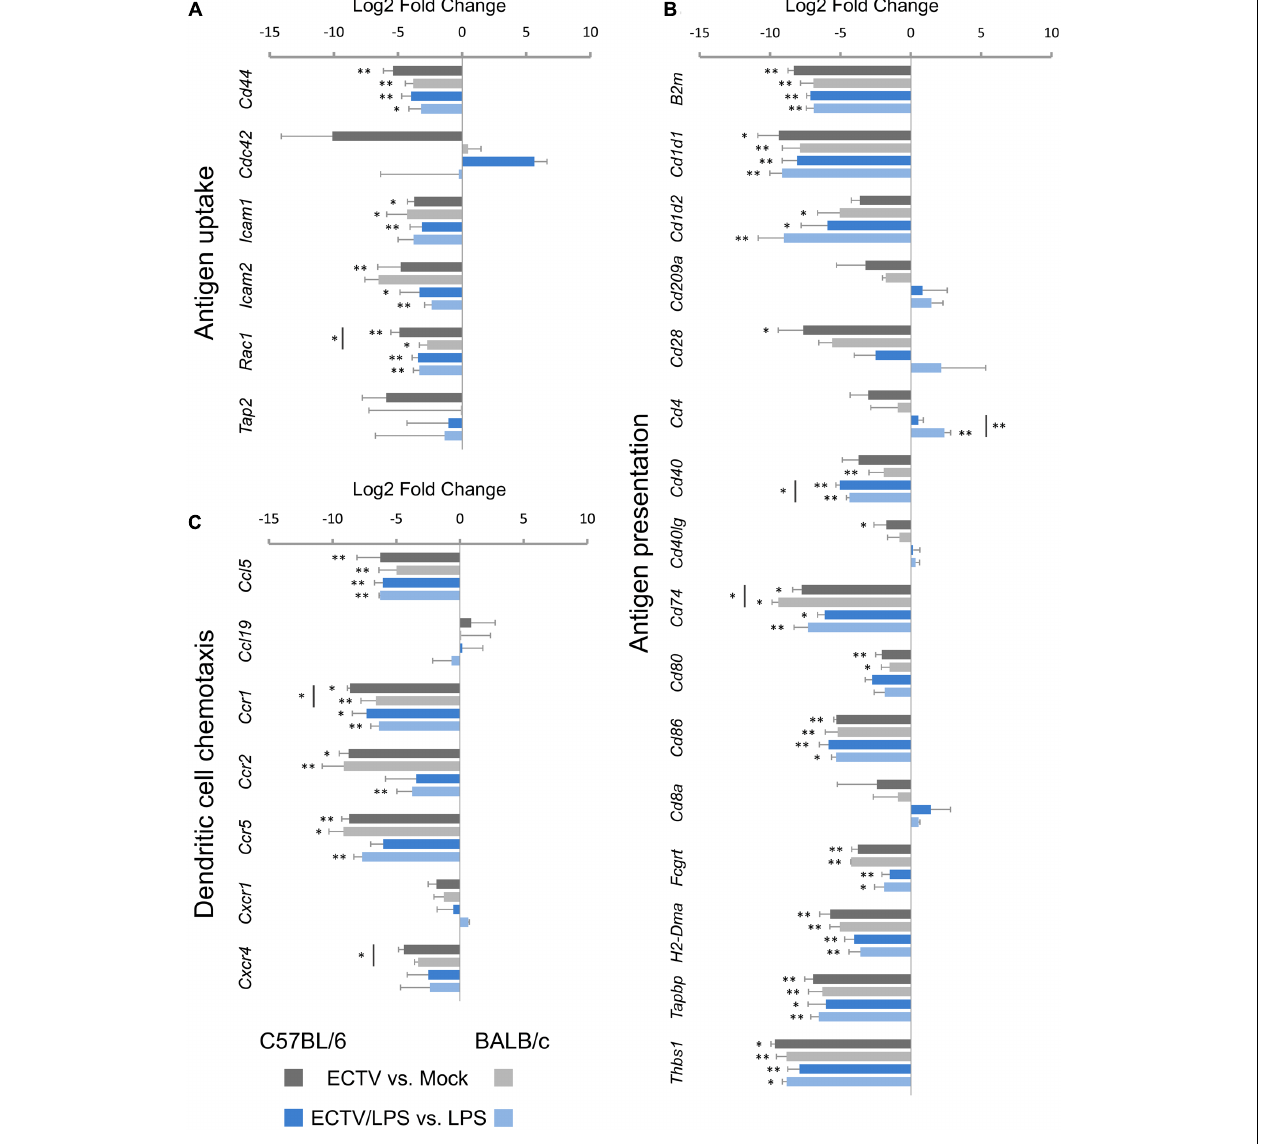
respectively. Cebpa , Irf7 and Stat3 were significantly ( P >